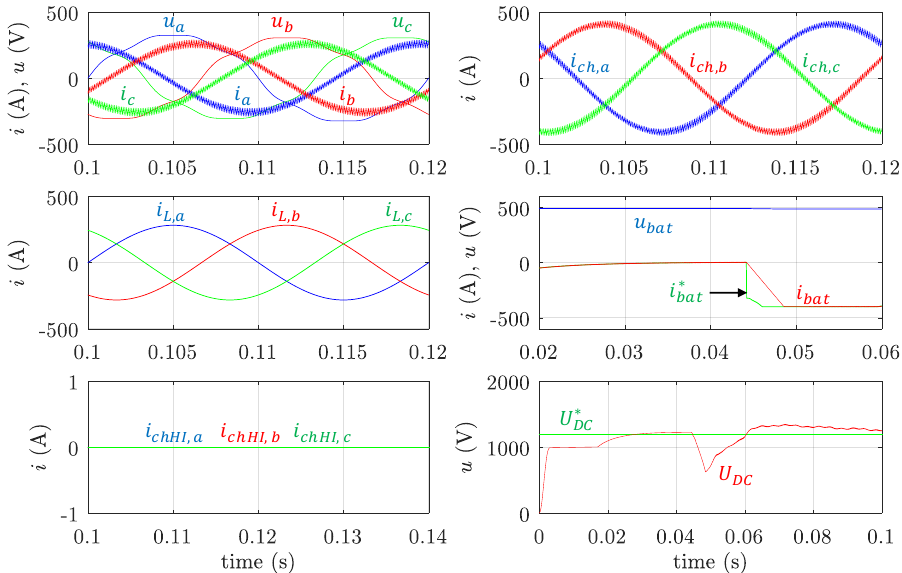
Figure 6. Simulation results. Case B. Discharging the battery and injecting fundamental reactive power: 𝑃 ∗ = – 160 kW, 𝑄 1∗ = 120 kVAr. CS demand without harmonics. 𝐼 𝐿 = 200 A.